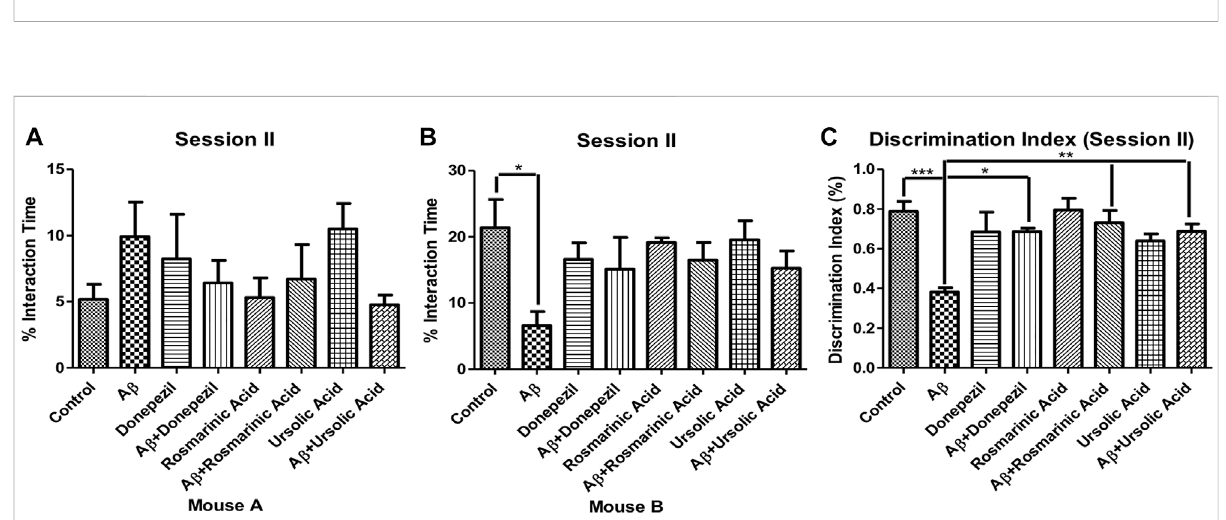
FIGURE 2 Effect of RA and UA on social novelty preference behavior. (A) Interaction time with the Mouse A. (B) Interaction time with the Mouse B. (C) Discrimination index during session II. Signi fi cance was analyzed by one-way ANOVA followed by Bonferroni comparison test (mean ± SEM)